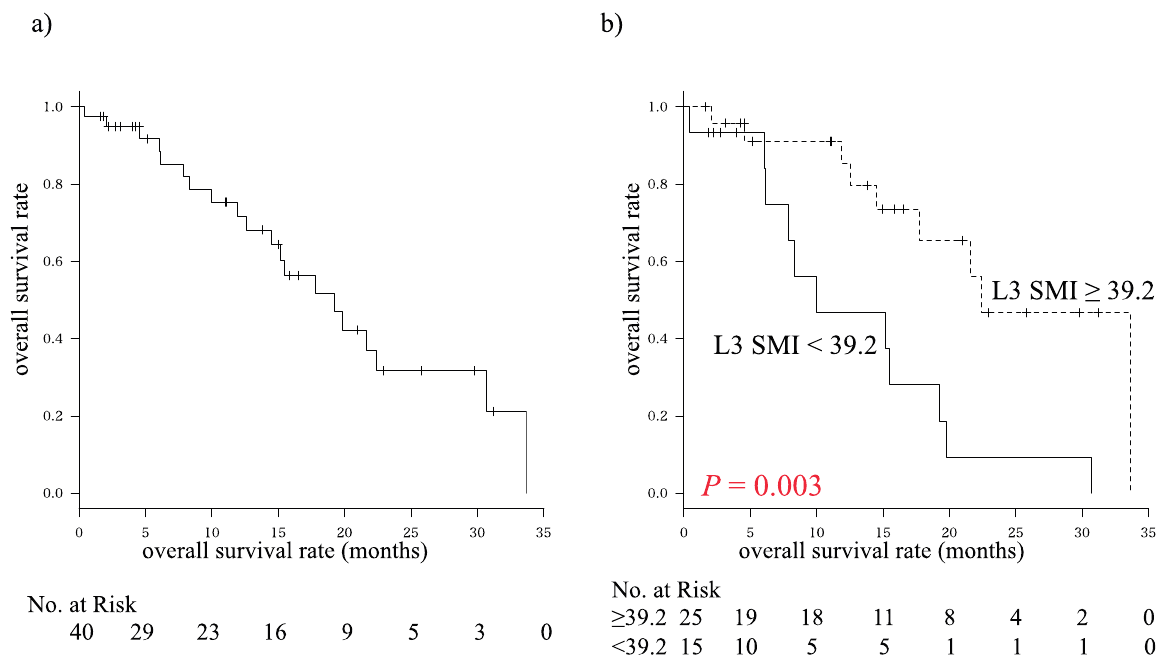
Figure 1. Kaplan–Meier curves for overall survival time in ( a ) all patients and ( b ) subgroups based on L3 skeletal muscle index (L3 SMI) (<39.2 and ≥ 39.2 (cm 2 /m 2